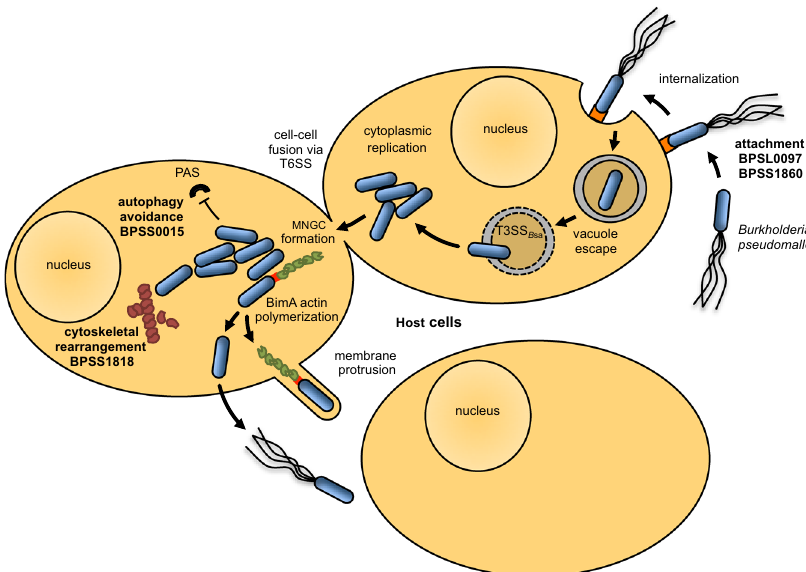
Fig. 5 Model of Bp intracellular pathogenesis. Bp attaches unknown receptors (orange) on host cells, using surface attachment proteins BPSL0097 and BPSS1860. After internalization, Bp escapes the vacuole utilizing the Burkholderia secretion apparatus (T3SS Bsa ) 23 and moves within the host cell using its secondary fl agella locus 26 or by polymerizing host cell actin (green) with bacterial BimA (red boxes on the bacterial cell pole) 30 . BPSS1818 facilitates changes in host cell cytoskeletal structure through modulation of tubulin (maroon), while BPSS0015 contributes to autophagy evasion. PAS: pre- autophagosomal structure. Bacteria replicate intracellularly and spread to neighboring cells by actin-based membrane protrusion and by promoting cell fusion to form multinucleated giant cells (MNGC) using a Type VI Secretion System (T6SS) 24,27,28